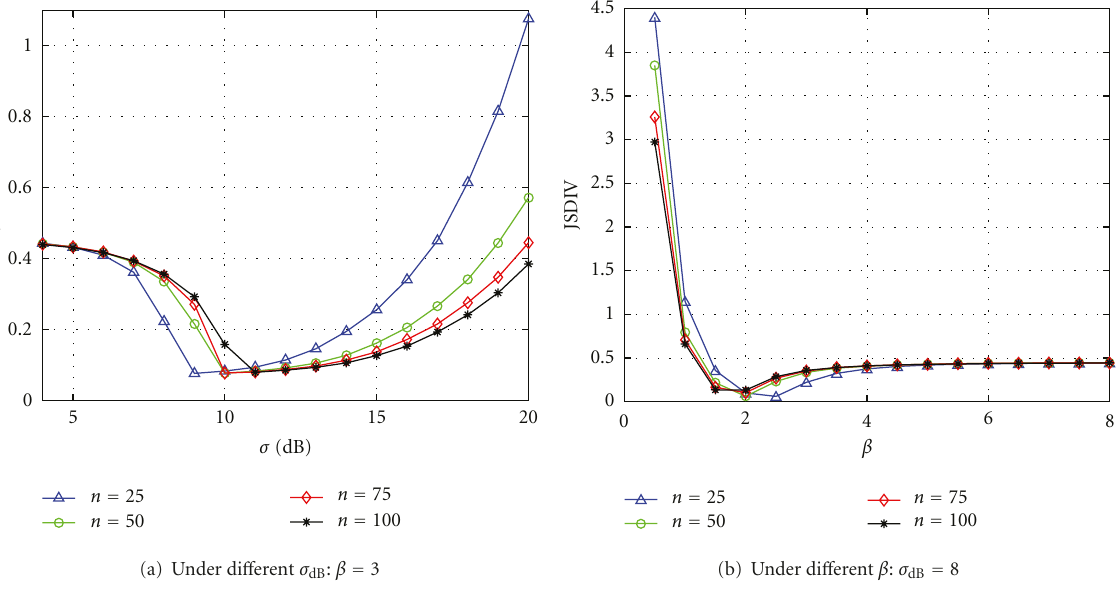
Figure 2: Jensen-Shannon divergence between " M n and Λ